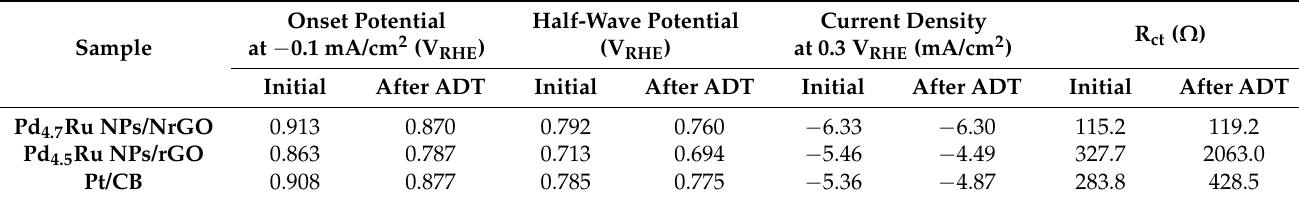
Figure 4. XPS spectra of ( a ) C 1s, ( b ) N 1s, ( c ) Pd 3d, and ( d ) Ru 3p of the Pd 4.7 Ru NPs/NrGO and Pd 4.5 Ru NPs/rGO. Table 2. Onset potentials, half-wave potential, and current densities of the Pd 4.7 Ru NPs/NrGO, Pd 4.5 Ru NPs/rGO, and Pt/CB, determined from LSV at initial and after ADT. R ct values of the Pd 4.7 Ru NPs/NrGO, Pd 4.5 Ru NPs/rGO, and Pt/CB, determined from EIS at initial and after CV